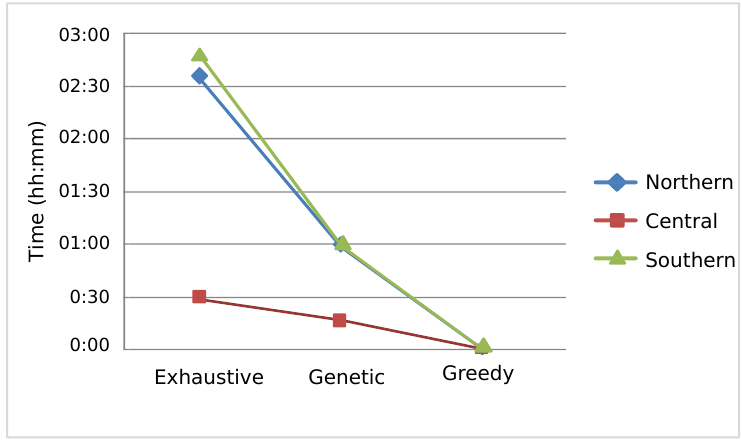
Figure 12. Benchmarking of the performance of the three